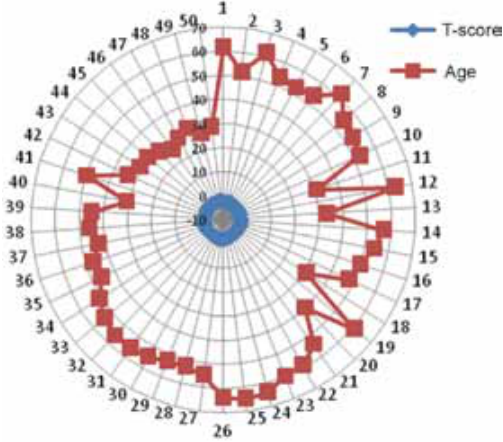
FIGURE 4. Correlation between t-score and age of the fe